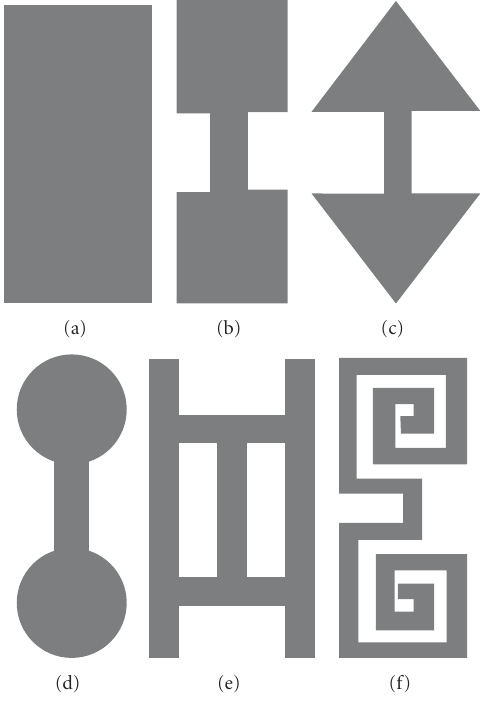
Figure 2: Di ff erent slots for DGS: (a) rectangular DGS, (b) square head DGS (dumbbell shape), (c) triangular DGS, (d) circular DGS, (e) H shape DGS, and (f) spiral